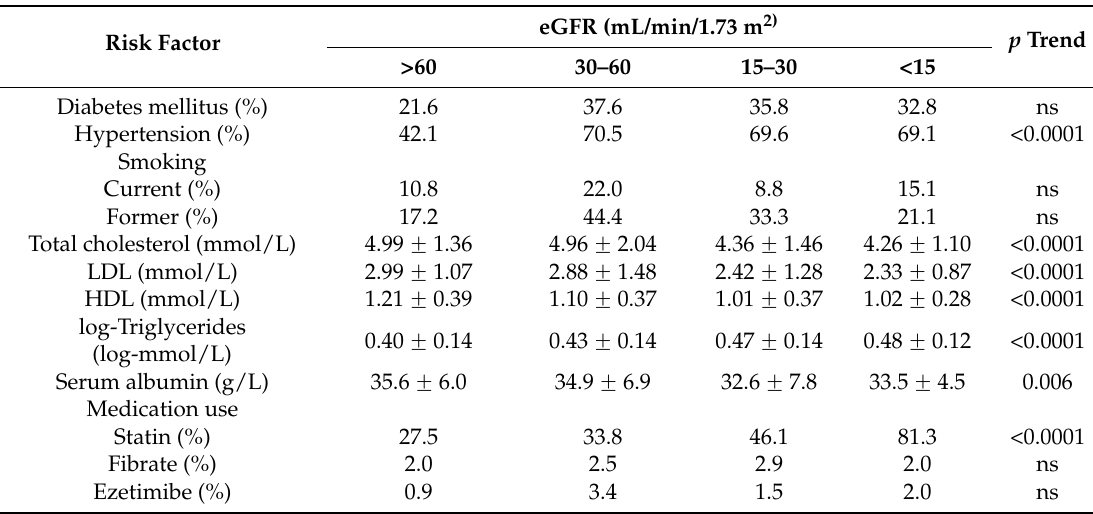
Table 1. Characteristics of 204 patients with ESKD compared to age- and gender-matched